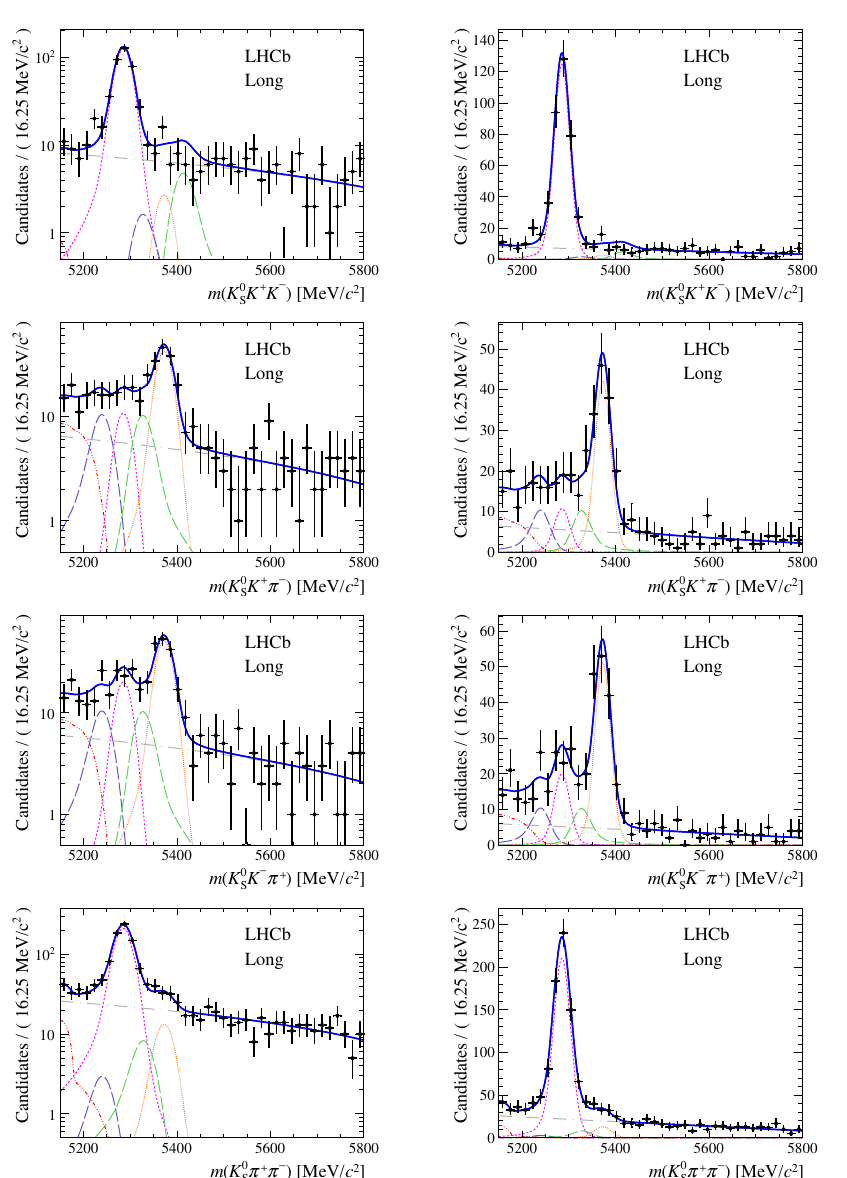
Figure 8 . Results of the simultaneous (cid:12)t to data (long, 2012b) with the BDT optimisation corre- sponding to the favoured decay modes. The modes K 0 are shown from top to bottom. The left-hand side plots show the results with a logarithmic scale and the right-hand side with a linear scale. Legend is similar to that of plots shown in (cid:12)gure 1.